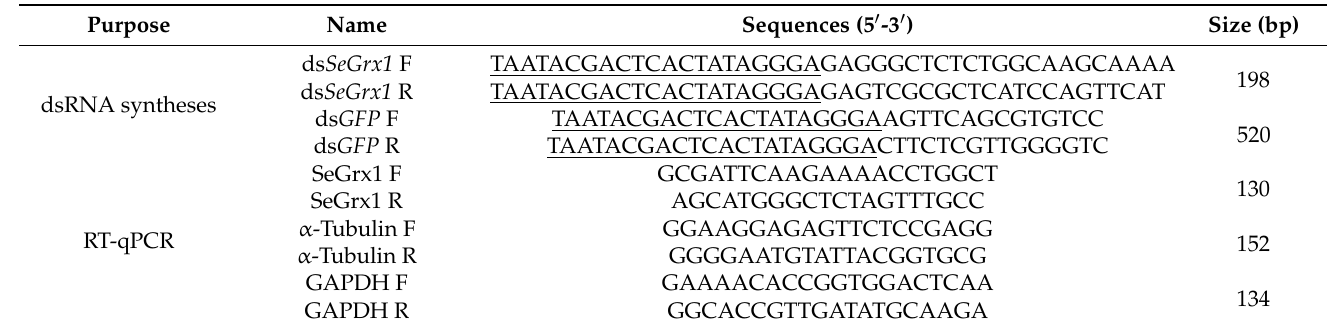
Table 1. Primers used for dsRNA synthesis and